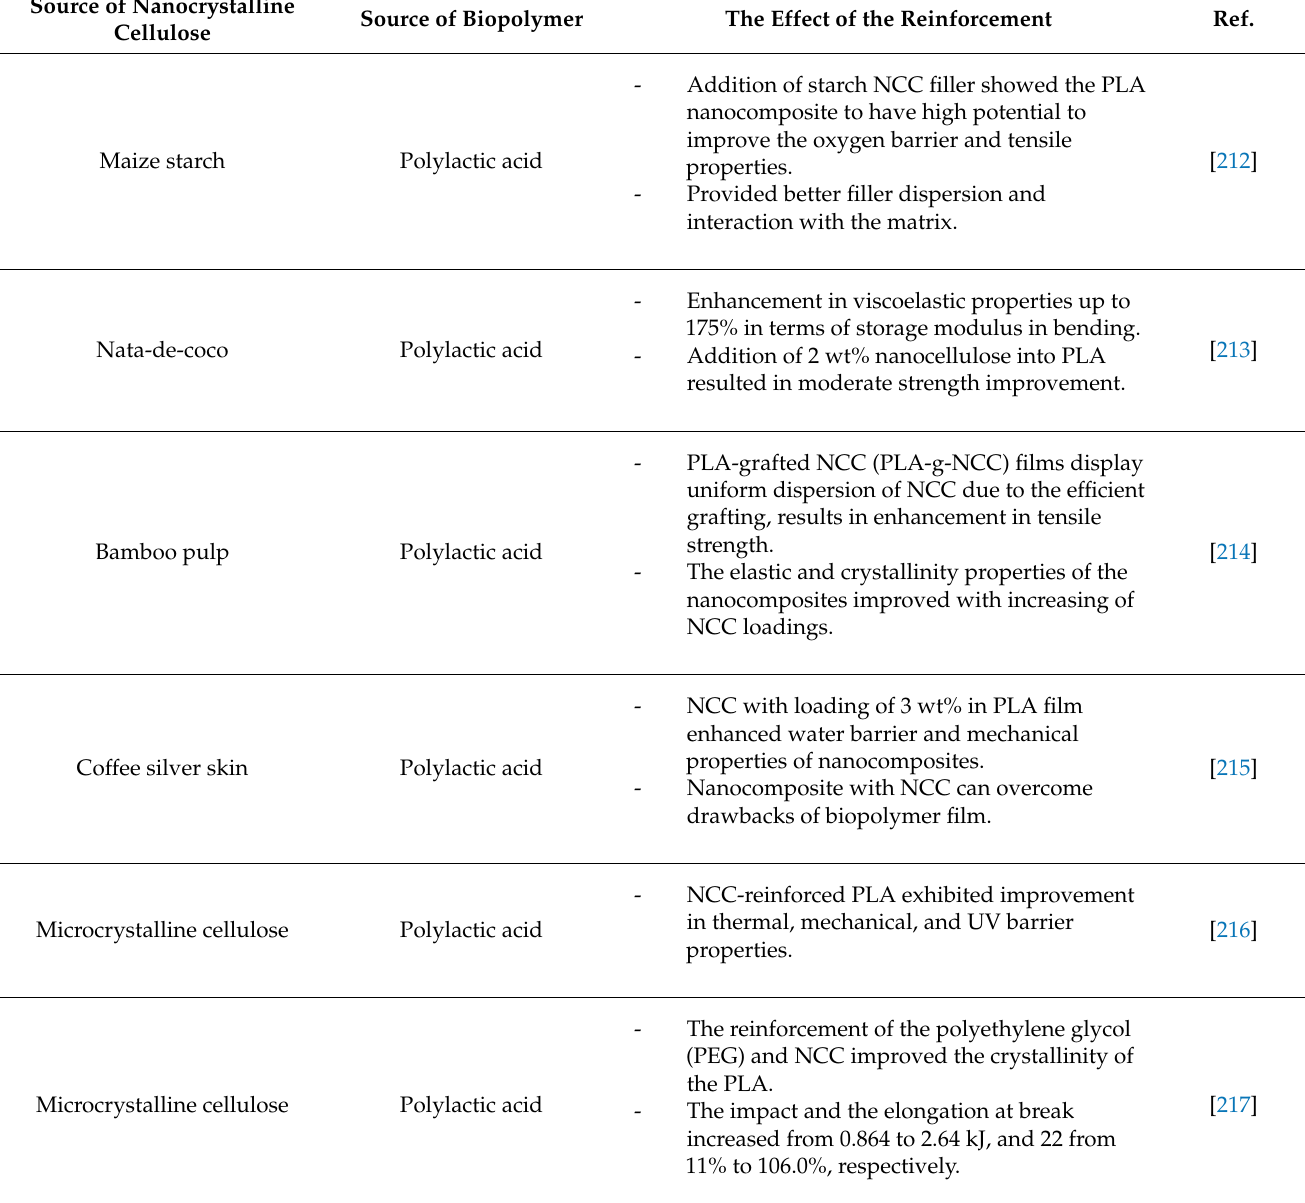
Table 3. Illustration of the effect of nanocrystalline cellulose on biopolymer matrix. Source of